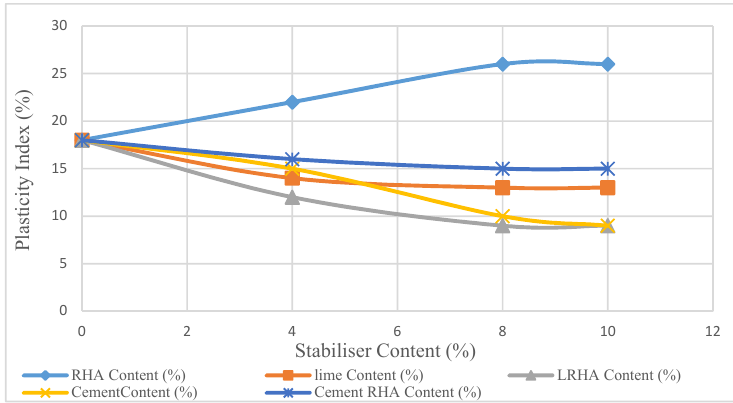
Figure 4. Effect of stabilizer contents on treated soil plasticity index after 14 days.